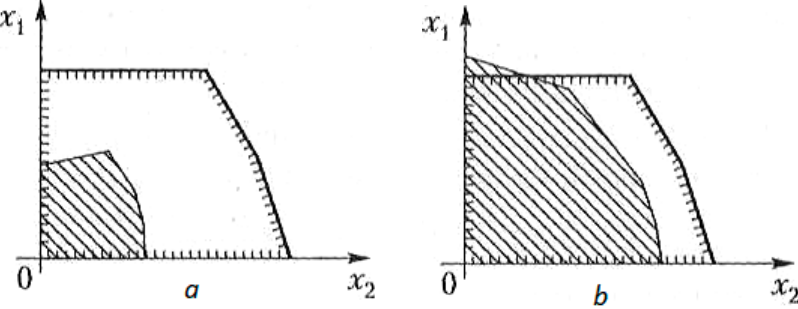
Figure 2. Allowable set of solutions. ( a ) “dirty” technologies; ( b ) “clean” technologies.